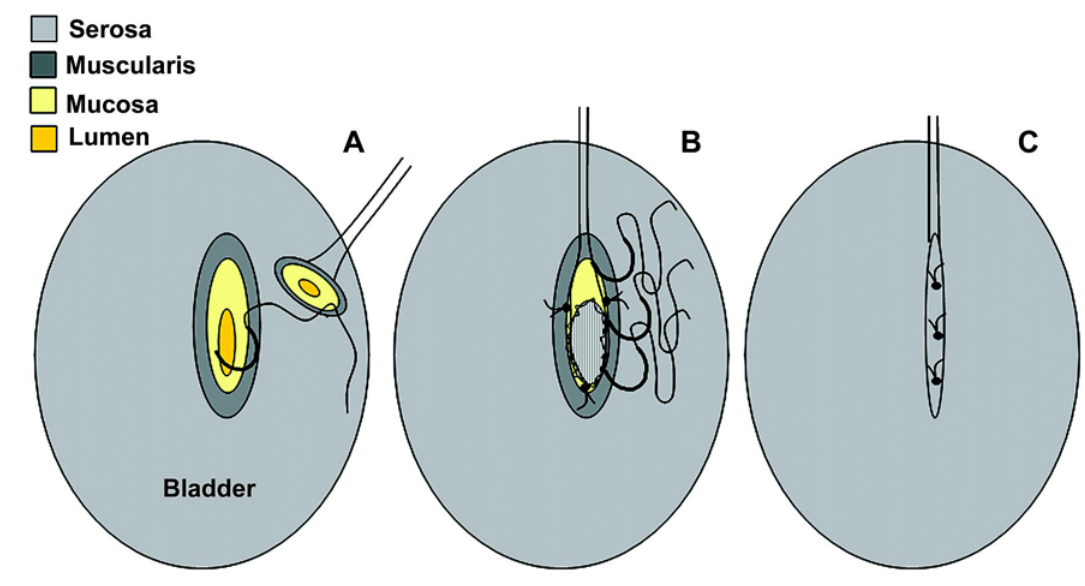
Figure 4 – Schematic drawings of the ureterovesical anastomosis steps, as shown in Figure-3.